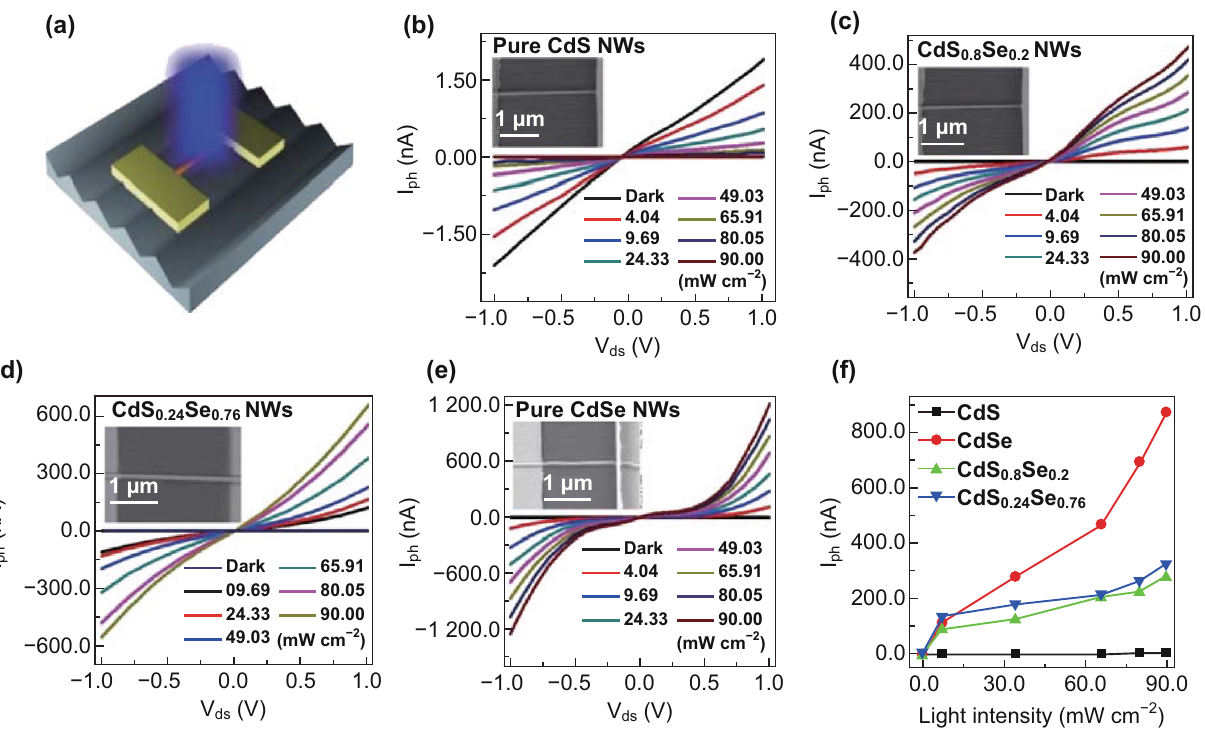
Fig. 4 I–V curves of the in-plane-directional CdS x Se 1 - x NWs. a Schematic diagram of the typical PD. b – e Representative I–V characteristics of the as-grown CdS photocurrent values for the CdS x Se 1 - x NW